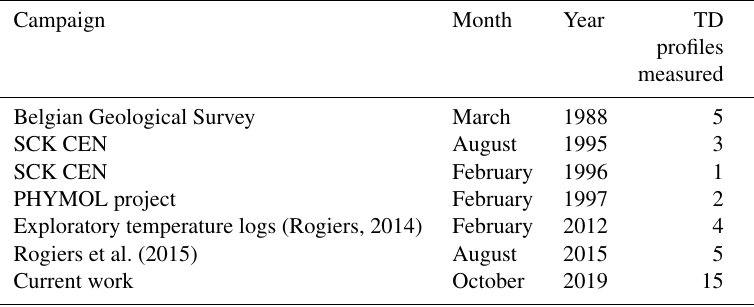
Table 1. Compiled historical TD profile data.